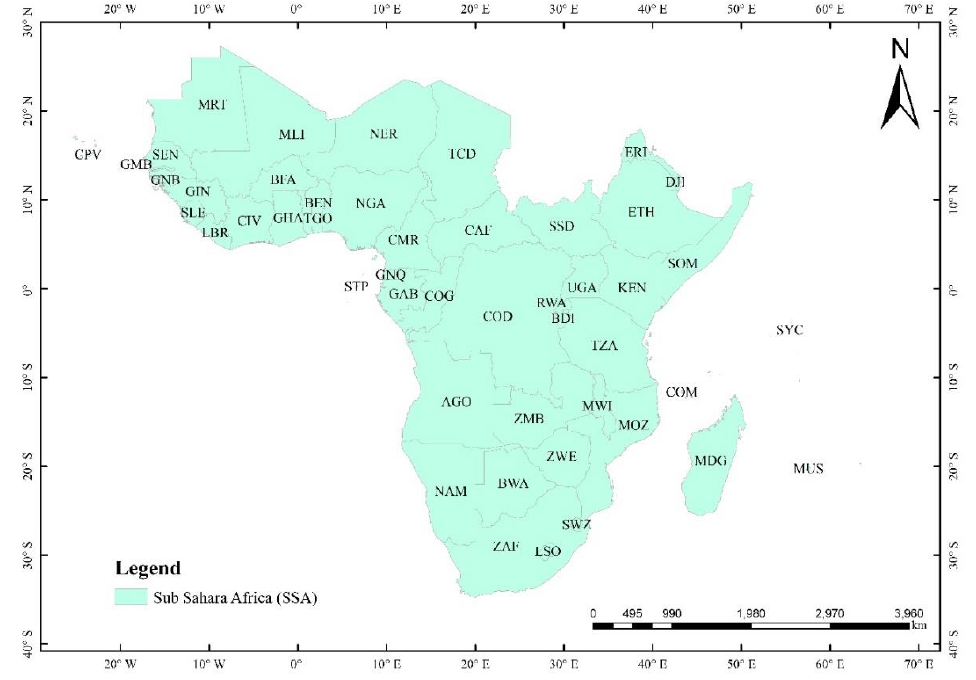
Figure 2. Map of the study area.